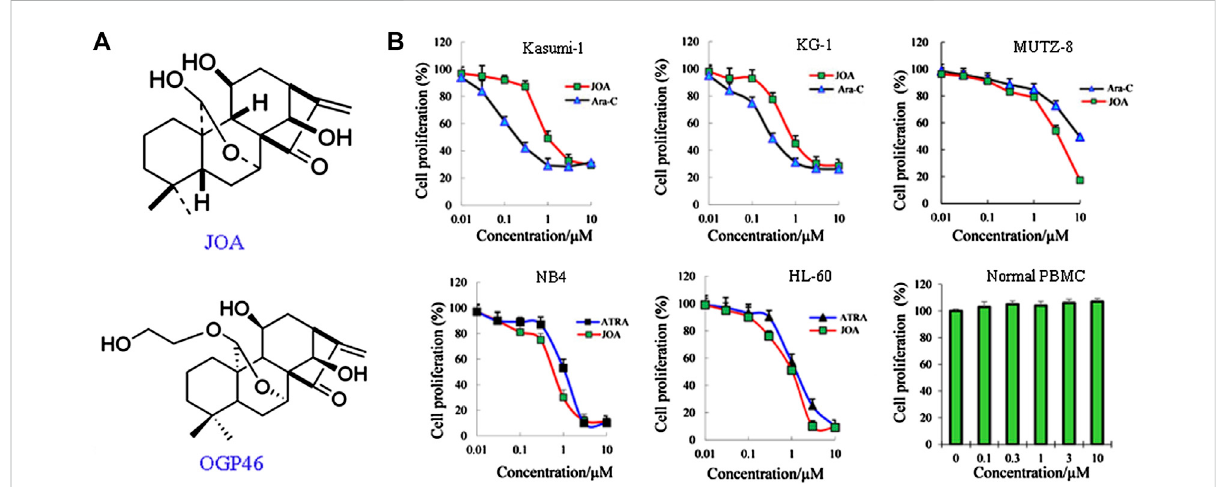
FIGURE 1 JOA inhibited cell proliferation of Kasumi-1, KG-1, MUTZ-8, NB4, HL-60 cells, and human normal peripheral blood mononuclear cells. (A) Chemical structure of JOA and OGP46. (B) Effect of JOA, Ara-C, or ATRA in the proliferation of cells at72 h. The points with error bars represent the mean ± SD. Figures are representative of three independent experiments performed in